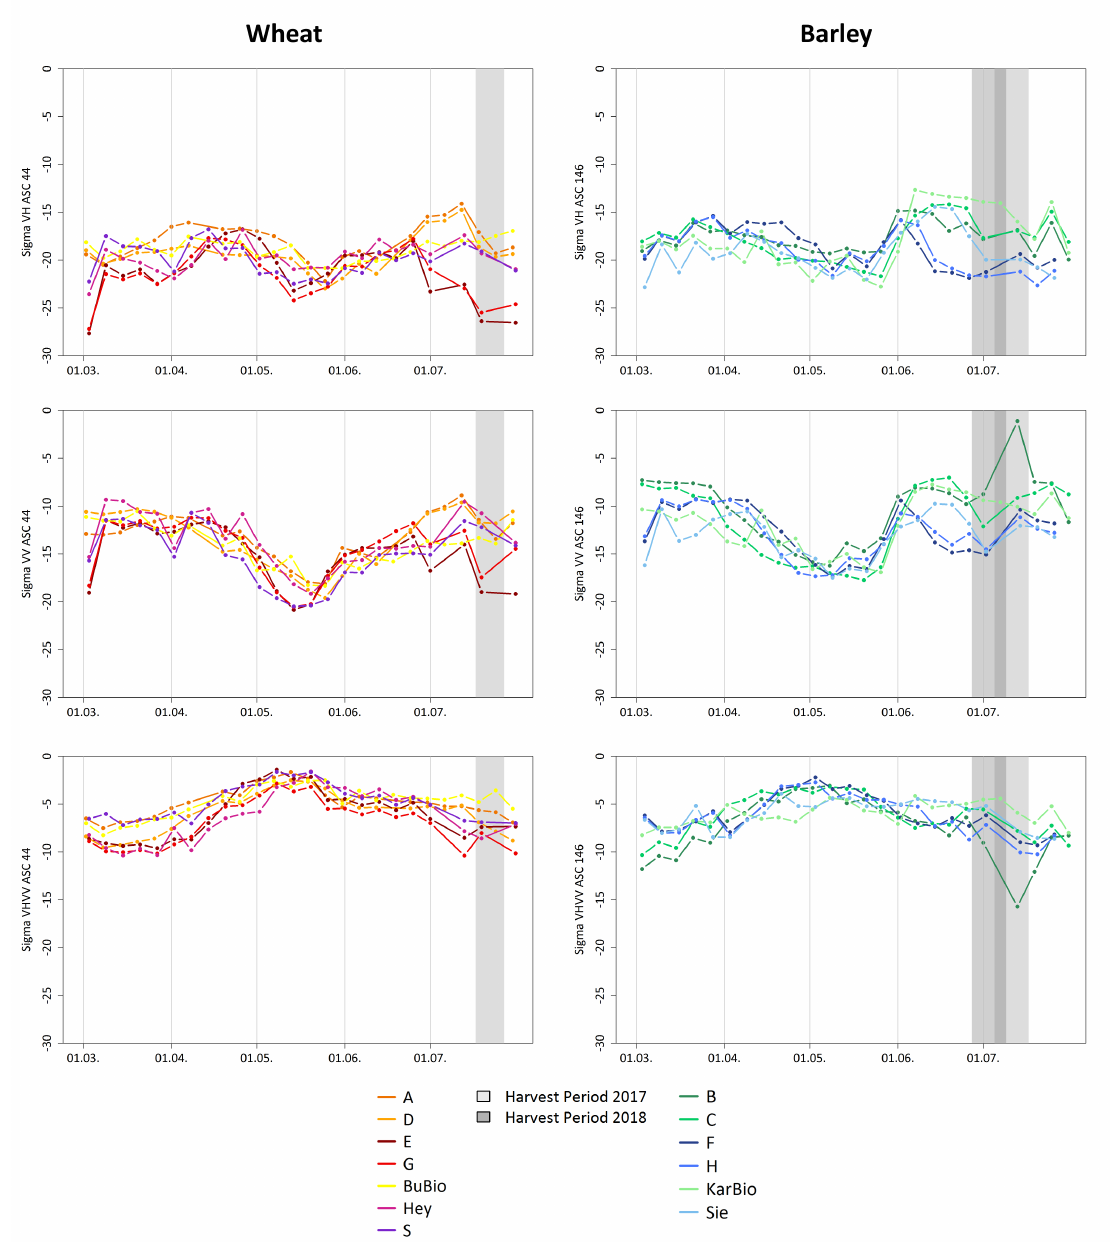
Figure 8. Temporal profiles of backscatter parameters VV, VH and VH/VV of all observed wheat fields ( left ) and barley fields ( right ).